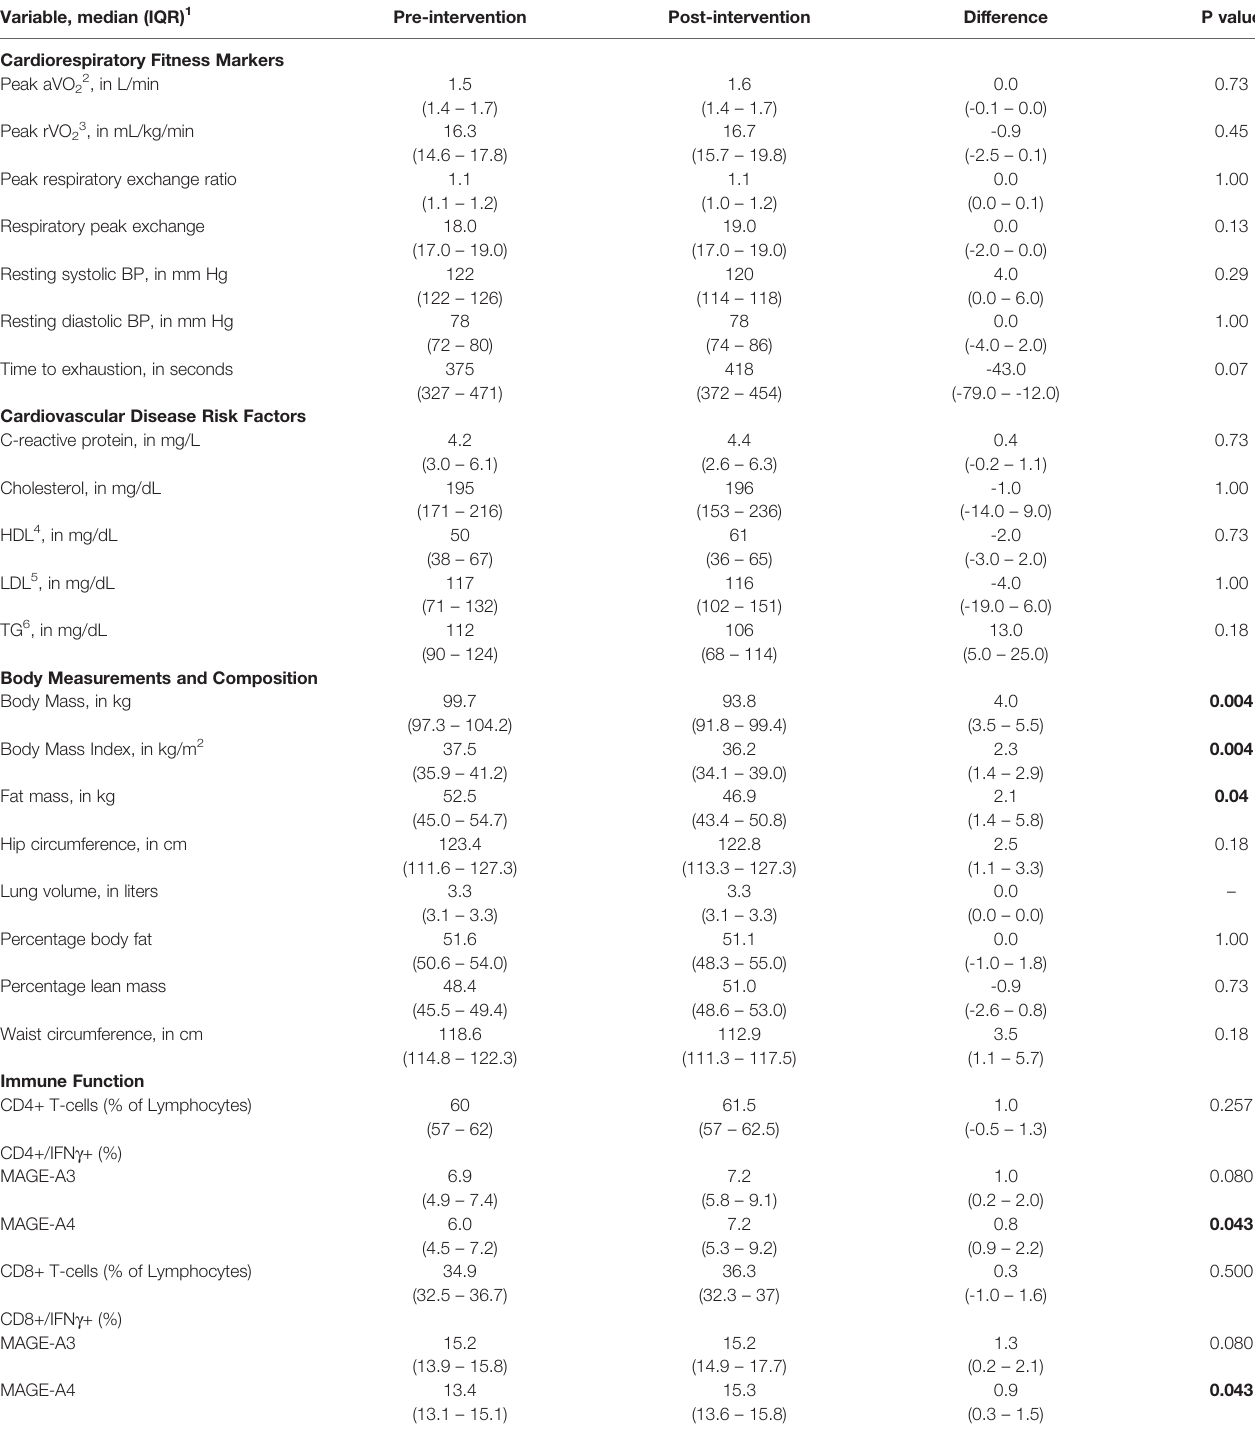
TABLE 3 | Pre and Post Intervention Markers of Cardiorespiratory Fitness, Cardiovascular Disease and Body